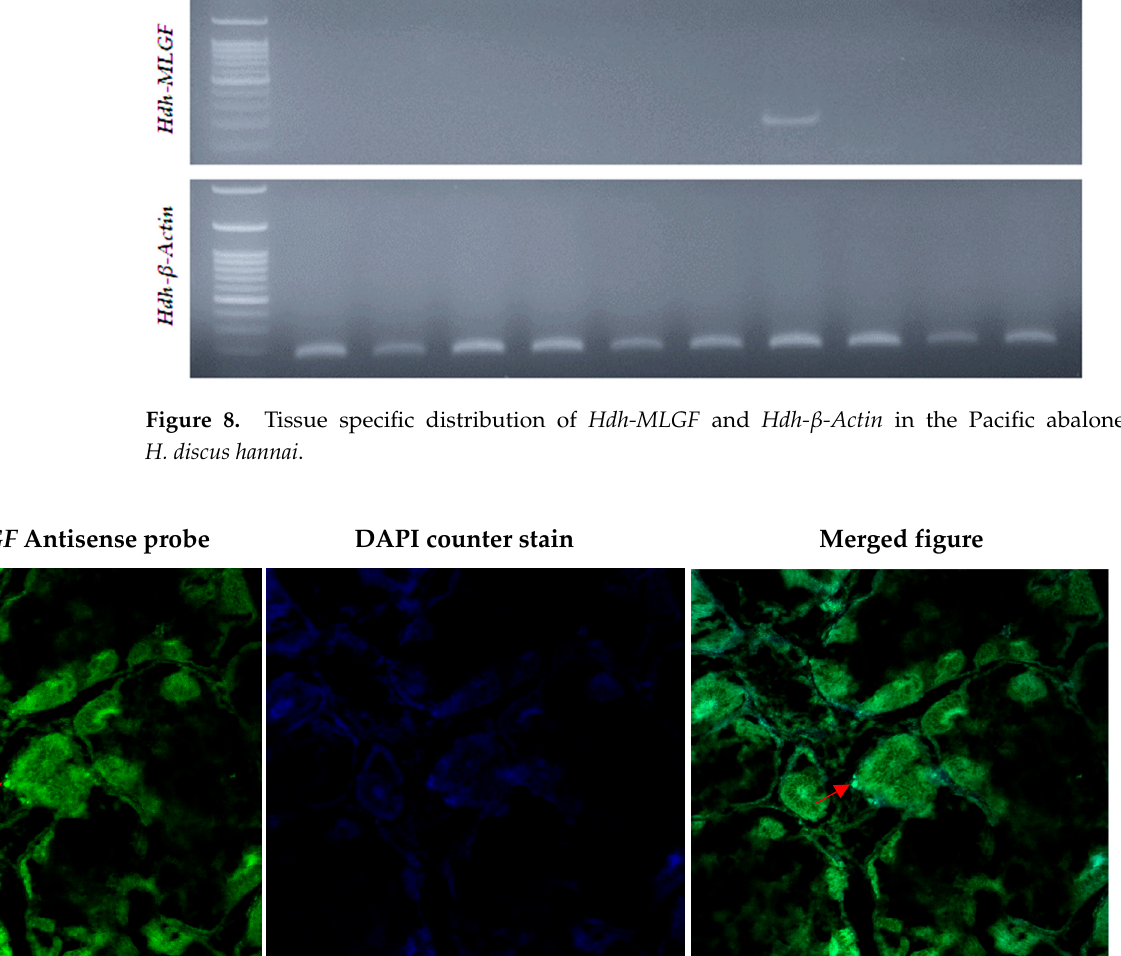
Figure 9. Microscopic (confocal laser scanning microscope) observation of Hdh-MLGF in digestive gland tissue of adult Pacific abalone using FISH.